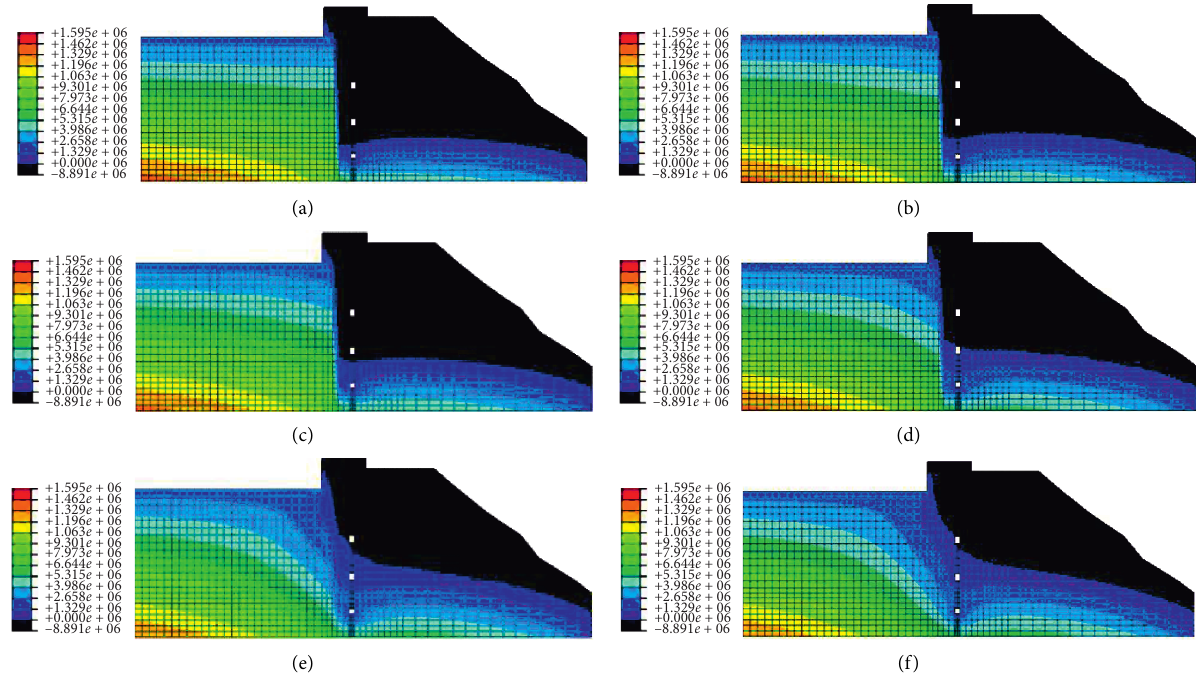
Figure 16: Distributions of the pore water pressure of the fractured rock mass (unit: Pa). (a) D � 0.1, (b) D � 0.45, (c) D � 0.5, (d) D � 0.6, (e) D � 0.75, and (f) D � 0.84.